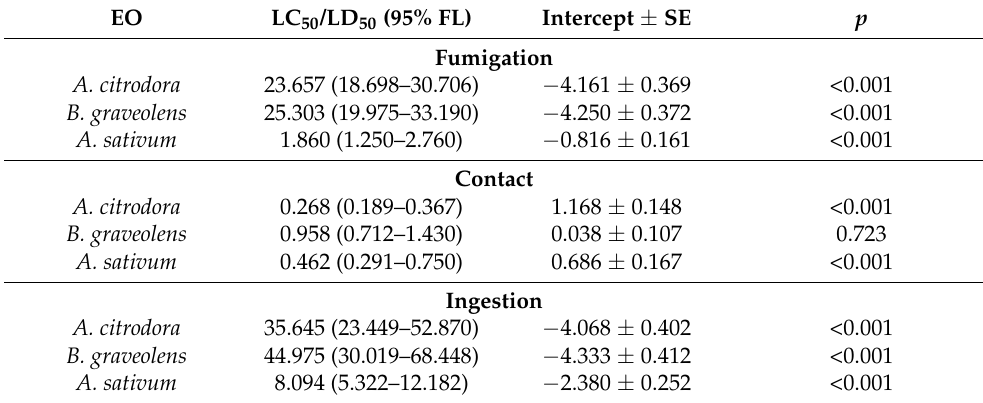
Table 4. Toxicity by fumigation, contact, and ingestion of Aloysia citrodora , Bursera graveolens , and Allium sativum essential oils (EOs) to adults of the blowfly Calliphora vomitoria .